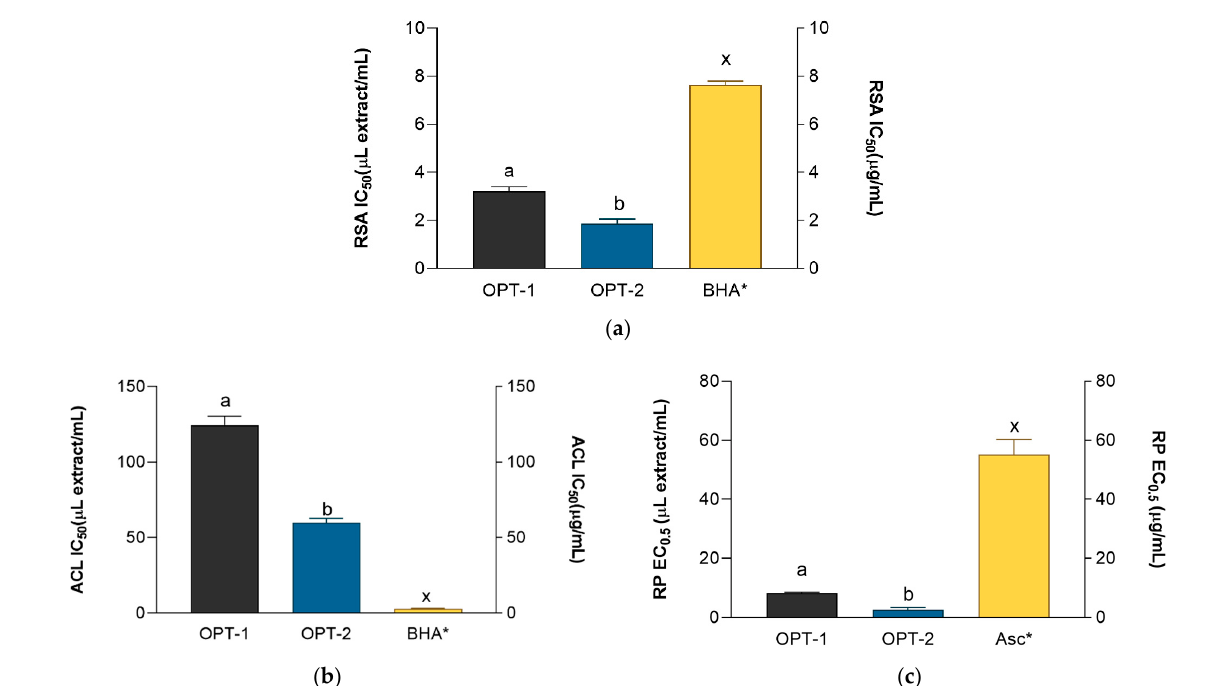
Figure 3. Antiradical activity ( a ), the activity in the β -carotene-linoleic acid assay ( b ), and the reducing power ( c ) of the OPT-1 and OPT-2 extracts (prepared as described in Section 2.6) and the positive controls, BHA (butylated hydroxyanisole) and Asc (ascorbic acid). a,b = differences between the extracts (Student’s t -test, p < 0.05). x = differences with the positive control (ANOVA followed by Dunnett’s post-test, p < 0.05). Columns not connected with the same letter are statistically different. The asterisk indicates that the unit is placed at the right ordinate.